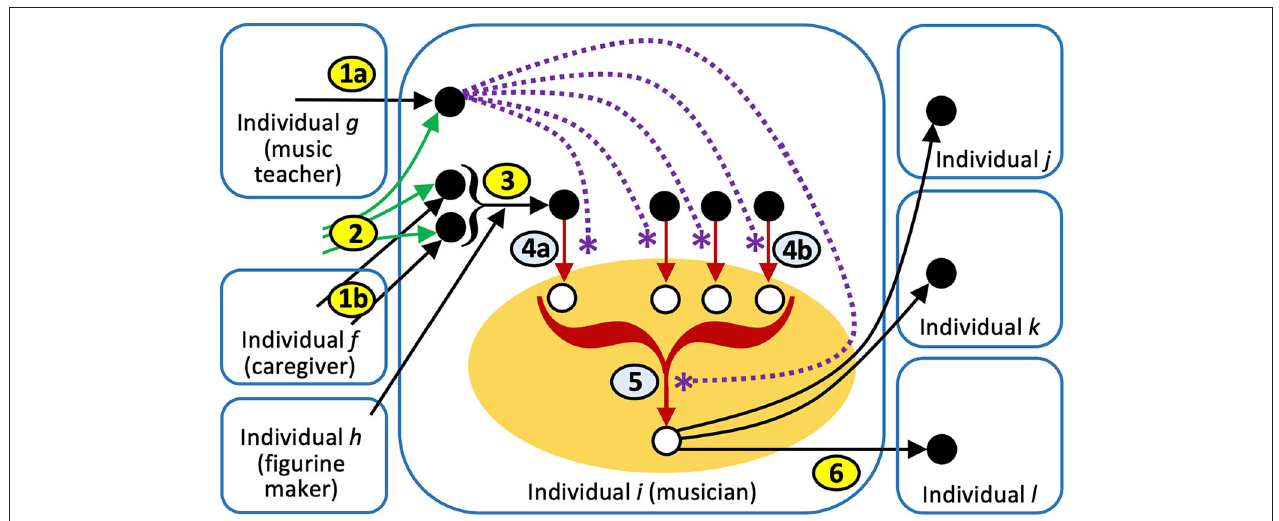
FIGURE 3 | Steps in the cross-domain transfer from figurine to music (These are the same six steps as in the previous figure; see text for details). Black arrows indicate social learning, green arrows indicate individual learning, red arrows indicate creative thought, dotted purple lines with stars indicate “catalysis” of a creative thought. Foodset items are black, and foodset-derived items are white. Since a particular concept, such as the concept of a lion-man hybrid, play different roles in different steps, it is not possible to use color and shapes to depict roles, as in Figure 2 . Orange oval represents the domain of music. Purple arrows in steps four and five represent “catalysis,” i.e., the facilitation of a creative thought that would otherwise be unlikely or difficult. These steps are catalyzed by musical knowledge, and the desire to express the experience of the figurine through the constraints of music. Note that since individual i obtained the products of step 5 through creative thought, it is not member a of the food-set in i , but it is a members of the food-set item in j , k , and l , because they obtained it from i through social